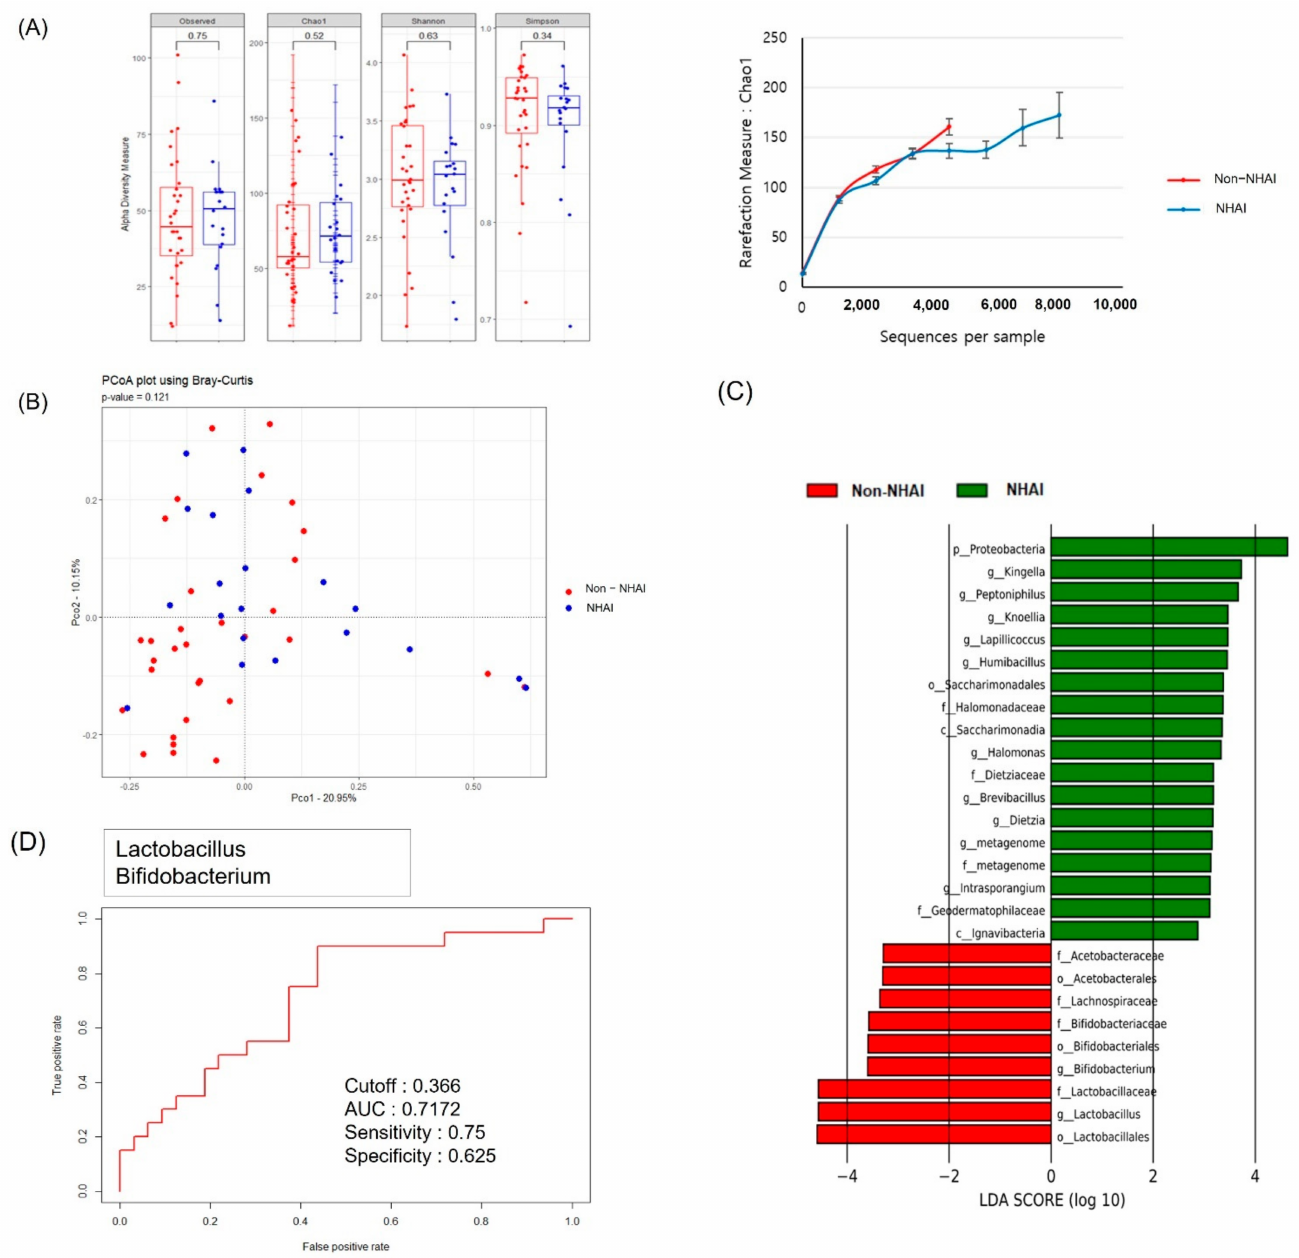
Figure 2. EVs in the plasma of the NHAI and non-NHAI groups. ( A ) α diversity measures and rarefaction curves based on the Chao1 index of species richness. ( B ) PCoA of plasma MEVs at the genus level. ( C ) LEfSe − based plasma MEV biomarkers. ( D ) ROC curves showing the accuracy of MEV strain to discriminate between NHAI and non-NHAI group. AUC 0.72 (95% CI 0.53,0.80) p = 0.240. NHAI: nursing home and hospital-associated infections; EV: extracellular vesicle; LEfSe: linear discriminant analysis effect size; ROC: receiver operating characteristic; AUC: area under the receiver operating characteristic curve. CI confidence interval; f: family; o: order; p: phylum; c: class; g: